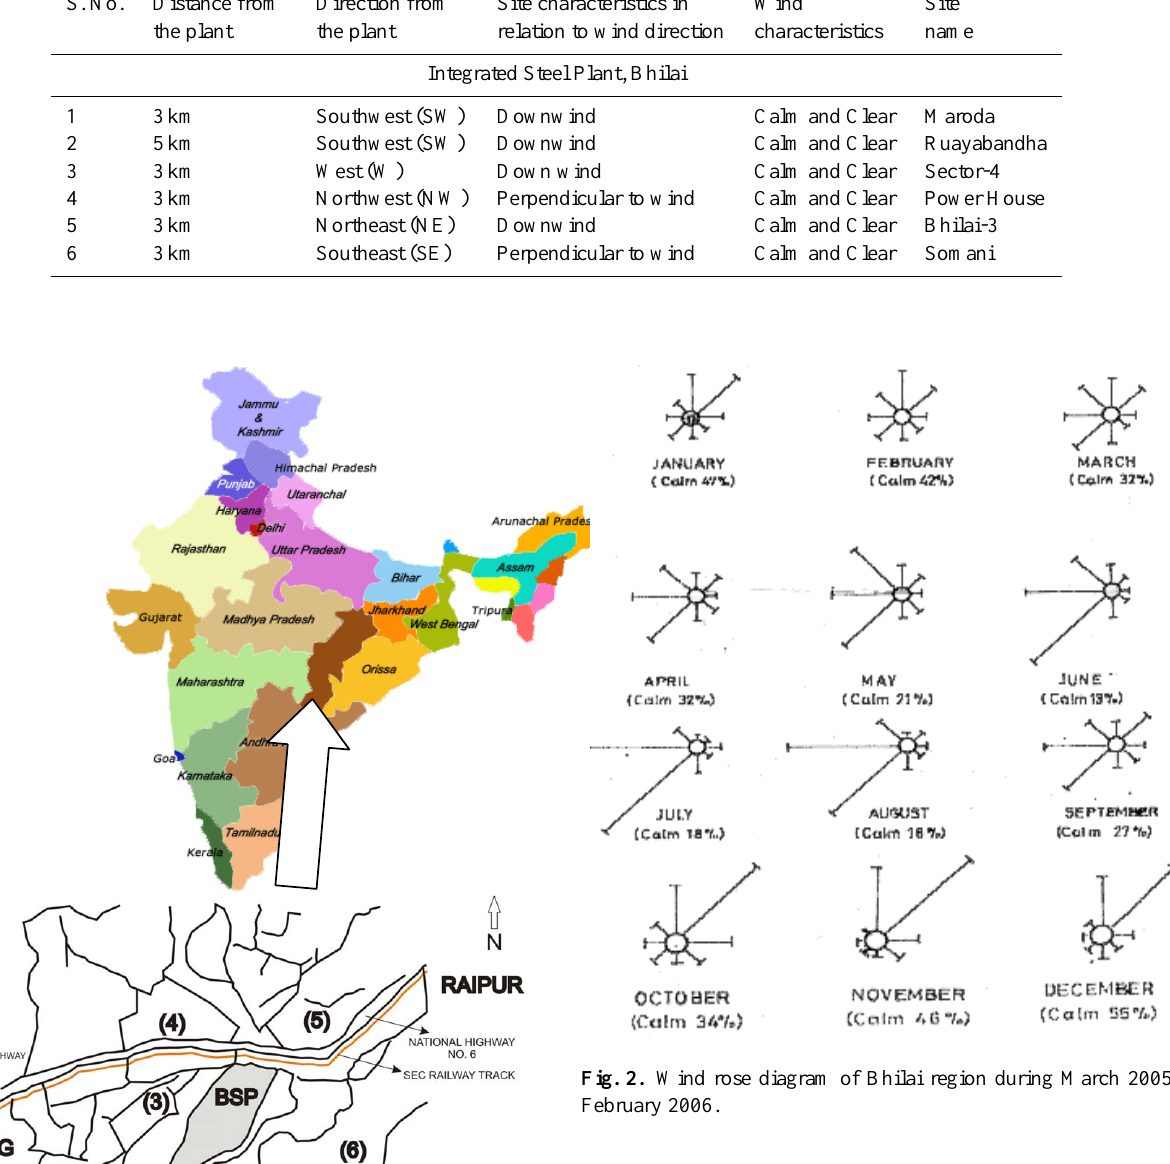
Table 1. Description of sampling sites for environmental monitoring of mercury around integrated steel plant, Bhilai, India. S. No.